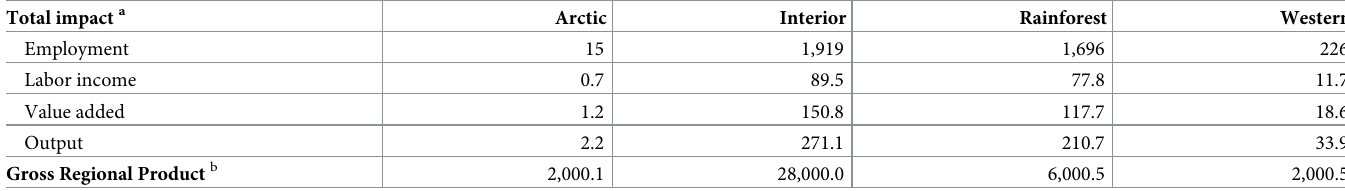
Table 5. Total economic impact of bird tourism by Alaska Bird Conservation Region and size of regional economies, 2021 US$ million.